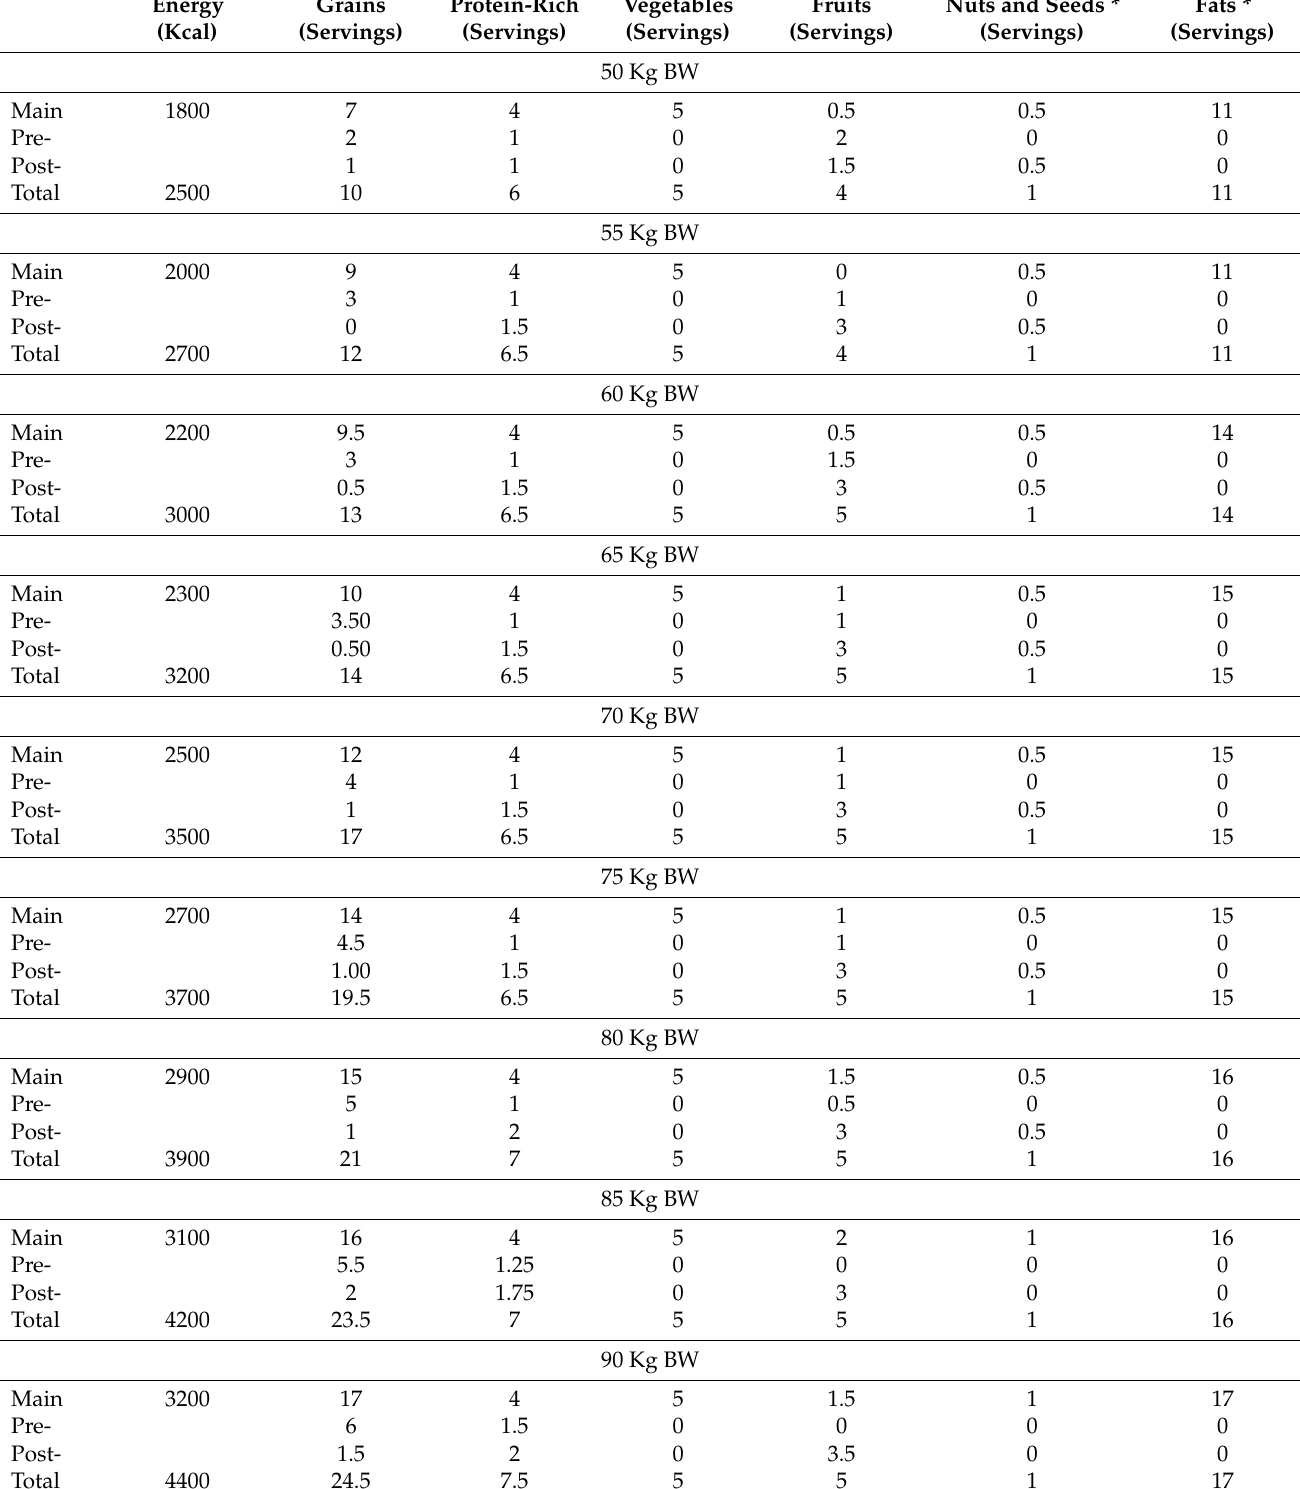
Table 3. Meal Planning of the VegPlate for